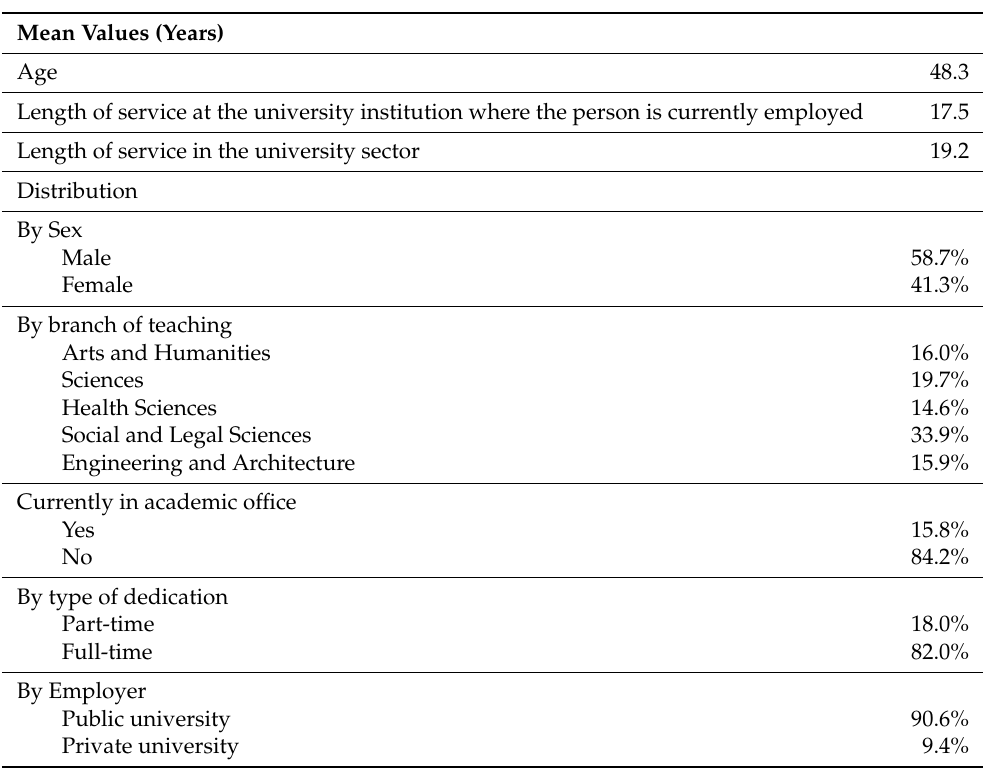
Table 2. Characteristics of the individuals in the